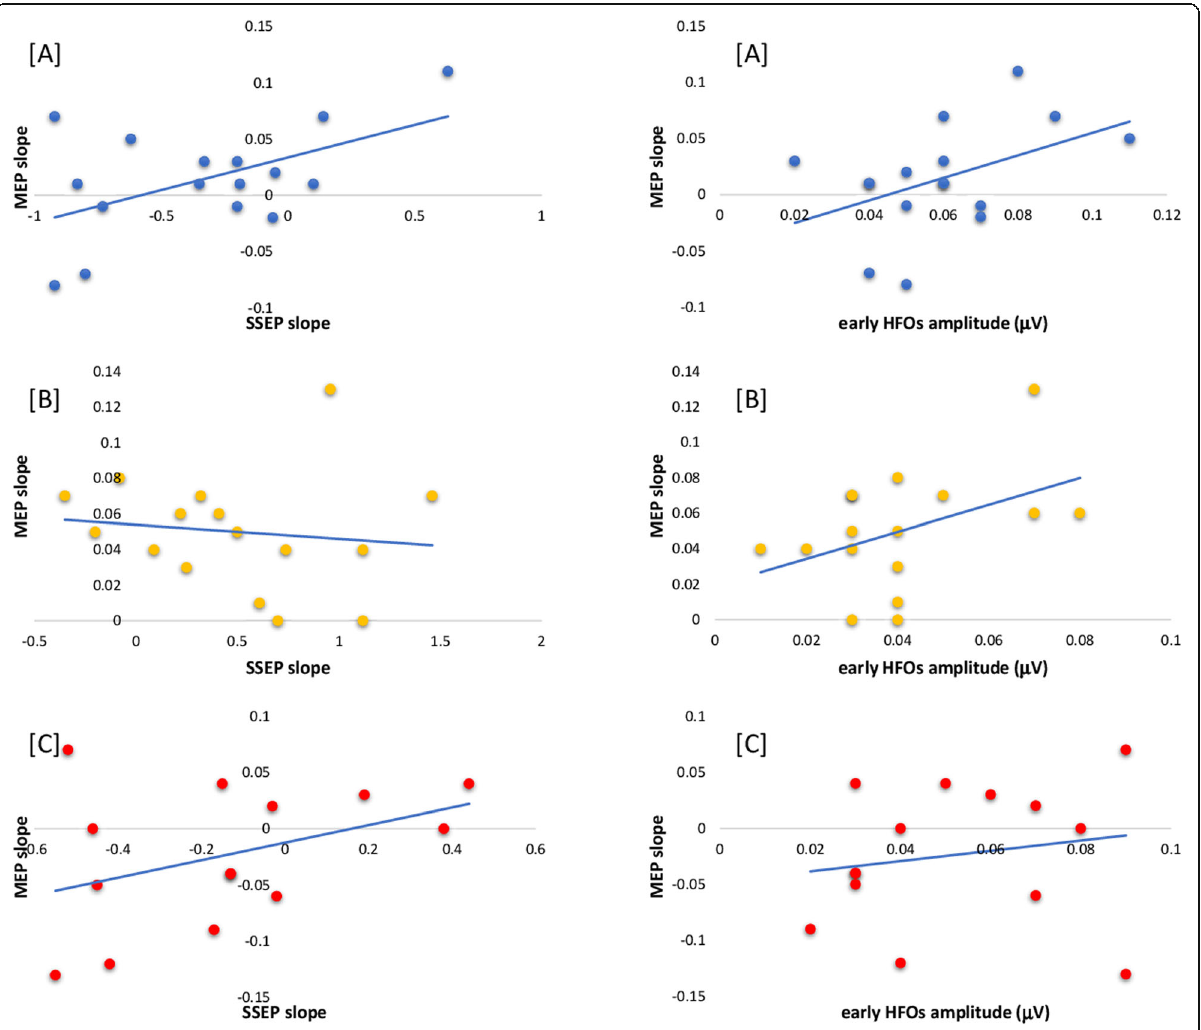
3 blocks of sequential recordings (x axis - left panels) or amplitude of the early burst of SSEP HFOs (x axis – right panels) in healthy volunteers ( a ) and